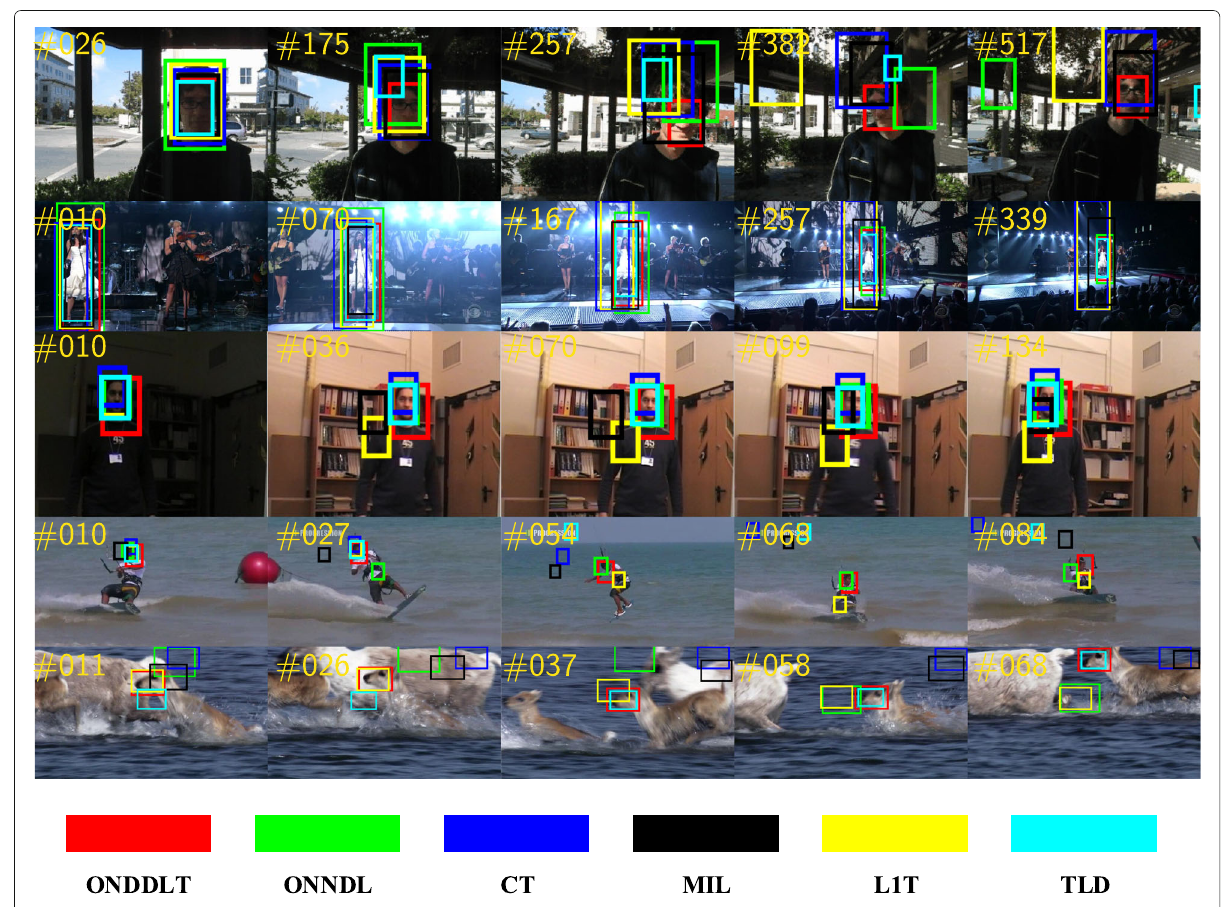
Fig. 4 Visualization performance of our method compared with other relative trackers on Trellis, Singer, Man, Kitesurf, and